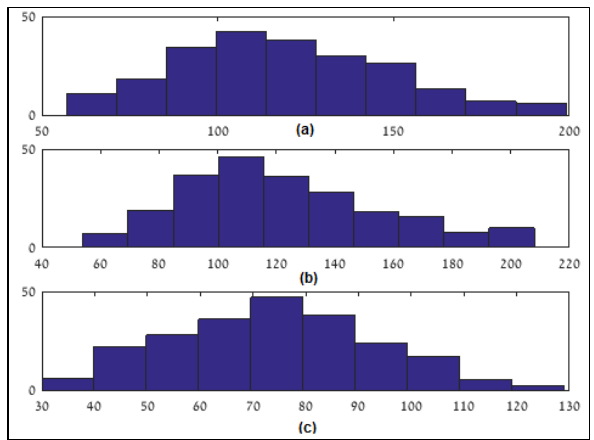
Figure 2. Spatial histograms of areas with and without oil spill (a) without oil spill (b) without oil spill (c) with oil spill.